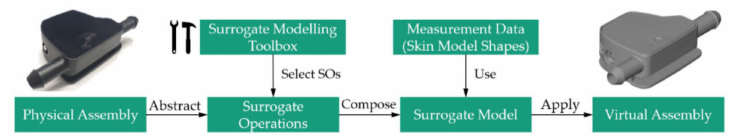
Figure 2. Generic concept of surrogate modelling for Virtual